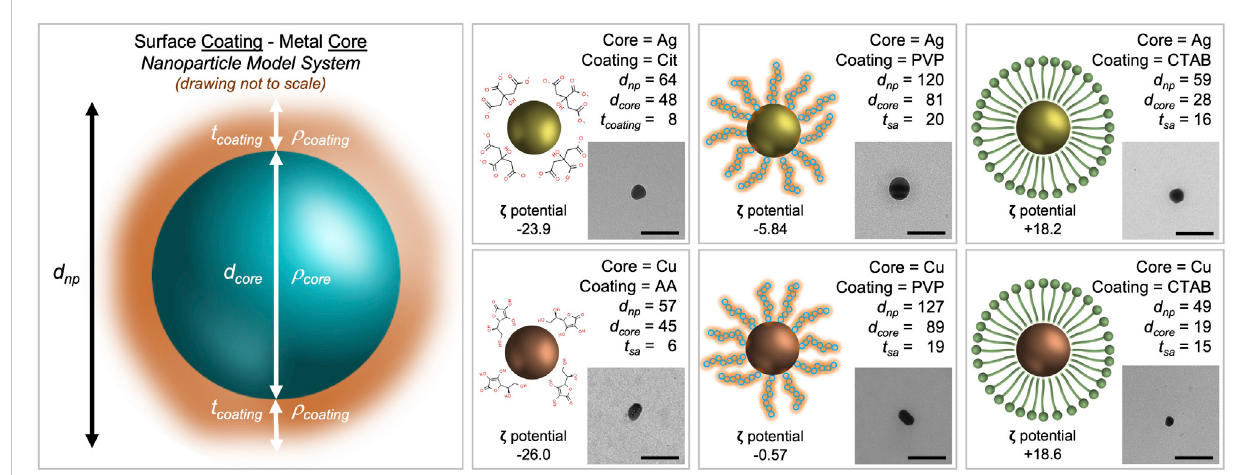
Morphological characterization scheme for metal nanoparticles with stabilizing agents. The core density ( ρ core ) and surface coating density ( ρ coating ) are assumed the same as the bulk density of the metal composition (silver (Ag) ρ core = 10.49 g/cm³ and copper (Cu) ρ core = 8.96 g/cm³) and surface coating (citrate (Cit) ρ coating = 1.66 g/cm³; ascorbic acid (AA) ρ coating = 1.65 g/cm³; polyvinylpyrrolidone (PVP) ρ coating = 1.25 g/cm³; cetyltrimethylammonium bromide (CTAB) ρ coating = 1.33 g/cm³). Transmission electron microscopy (TEM) is the method used to assess core diameter ( d core ); this technique does not provide suf fi cient information about the surface coating (due to the low contrast of organic material). Fourier transforminfrared(FTIR)spectroscopyisusedtoprovideevidenceofnanoparticleassociatedsurfacecoating(SupplementaryFigureS1).Thediameterof the nanoparticle core is measured relative to the scale bar (100 nm) and is reported as the average of more than 500 particles. To measure total nanoparticle diameter ( d np ), dynamic light scattering (DLS) is used. By subtracting the diameter of the core ( d core as measured by TEM) from the hydrodynamic diameter of the total particle system ( d np ) and dividing by 2, the thickness of the surface coating is estimated ( t shell (cid:2) d np − d core microscopy (AFM) is used to verify TEM and DLS measurements (Supplementary Figure S1). No single technique can measure all the morphological parameters of a nanoparticle system with a single